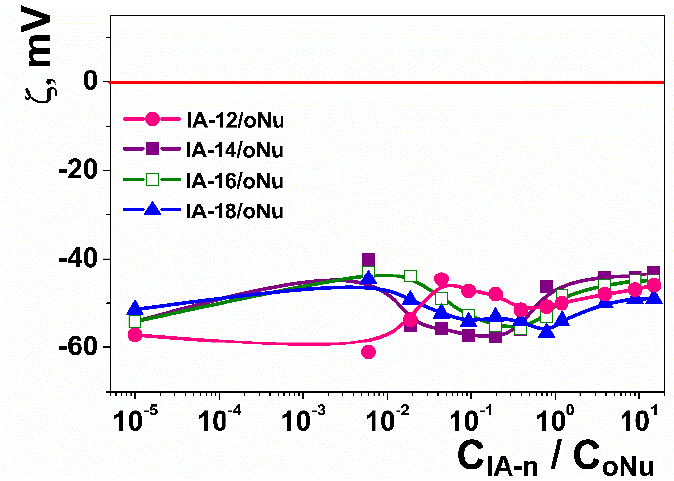
Figure 7. Electrokinetic potential versus amphiphile/oNu molar ratio for the IA-12/oNu, IA- 14/oNu [45], IA-16/oNu [45] and IA-18/oNu [45] binary systems; 25 °C. To test whether a DNA oligomer can be used for the reliable prediction of the binding behavior of macromolecular analogs, electrophoretic analysis involving pDNA was carried out (Figure 8), which demonstrated that IA-12 does not bind with pDNA in a wide concen- tration range of the amphiphile. Some retardation of both supercoiled and relaxed forms of pDNA was, however, observed at increased N/P ratios from 38:1 to 300:1, indicating a weak interaction of the cationic surfactant with pDNA. The typical cationic surfactant CTAB used as a reference compound was shown to completely bind pDNA at an N/P ratio of 14:1 (Figure S9). The DNA-binding ability of CTAB was inferior to that observed for cationic polymers such as cationic polyaspartamides with an N/P ratio as low as 1:1 [46]. These data are in good agreement with the above zeta potential results of the IA-12/oNu complexes, testifying that electrostatic interactions play a minor role in the complexation. Unlike ammonium surfactants, imidazolium head groups with delocalized cationic charge give an insufficient contribution to phosphate anion neutralization.